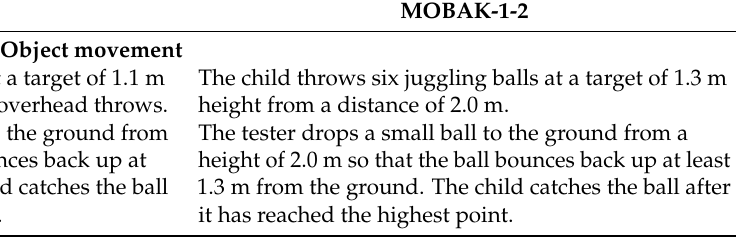
Table 1. Descriptions of the test items (see Herrmann, 2018 (p. 15) and 2020 (p. 8–9) [1,32]). Note: 0 = no attempt completed, 1 = task completed once, 2 = task completed twice.